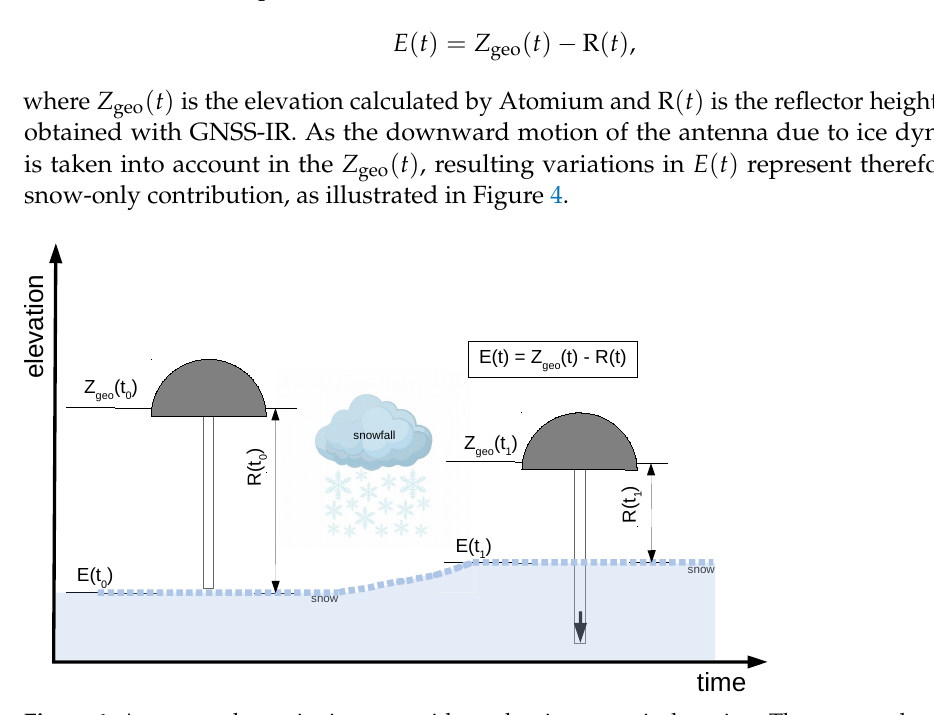
Figure 4. Antenna schematics in areas with predominant vertical motion. The antenna horizontal position is considered fixed in time, and its elevation variations are only due to its vertical sinking combined with potential snowfall. E ( t ) indicates the reflecting surface elevation, R ( t ) is the reflector height, and Z geo ( t ) is the vertical position of the antenna phase center Written as it is, Equation 4 is however only valid if the antenna is located on an ice rise, where the primary antenna motion occurs in the vertical direction. Elsewhere, another important parameter to be considered is the possible antenna downhill drift due to its location on a moving glacier. In this case, the vertical motion of the antenna phase center Zgeo(t) is not only due to the mast sinking, but a second component associated to the glacier motion must be considered (see Figure